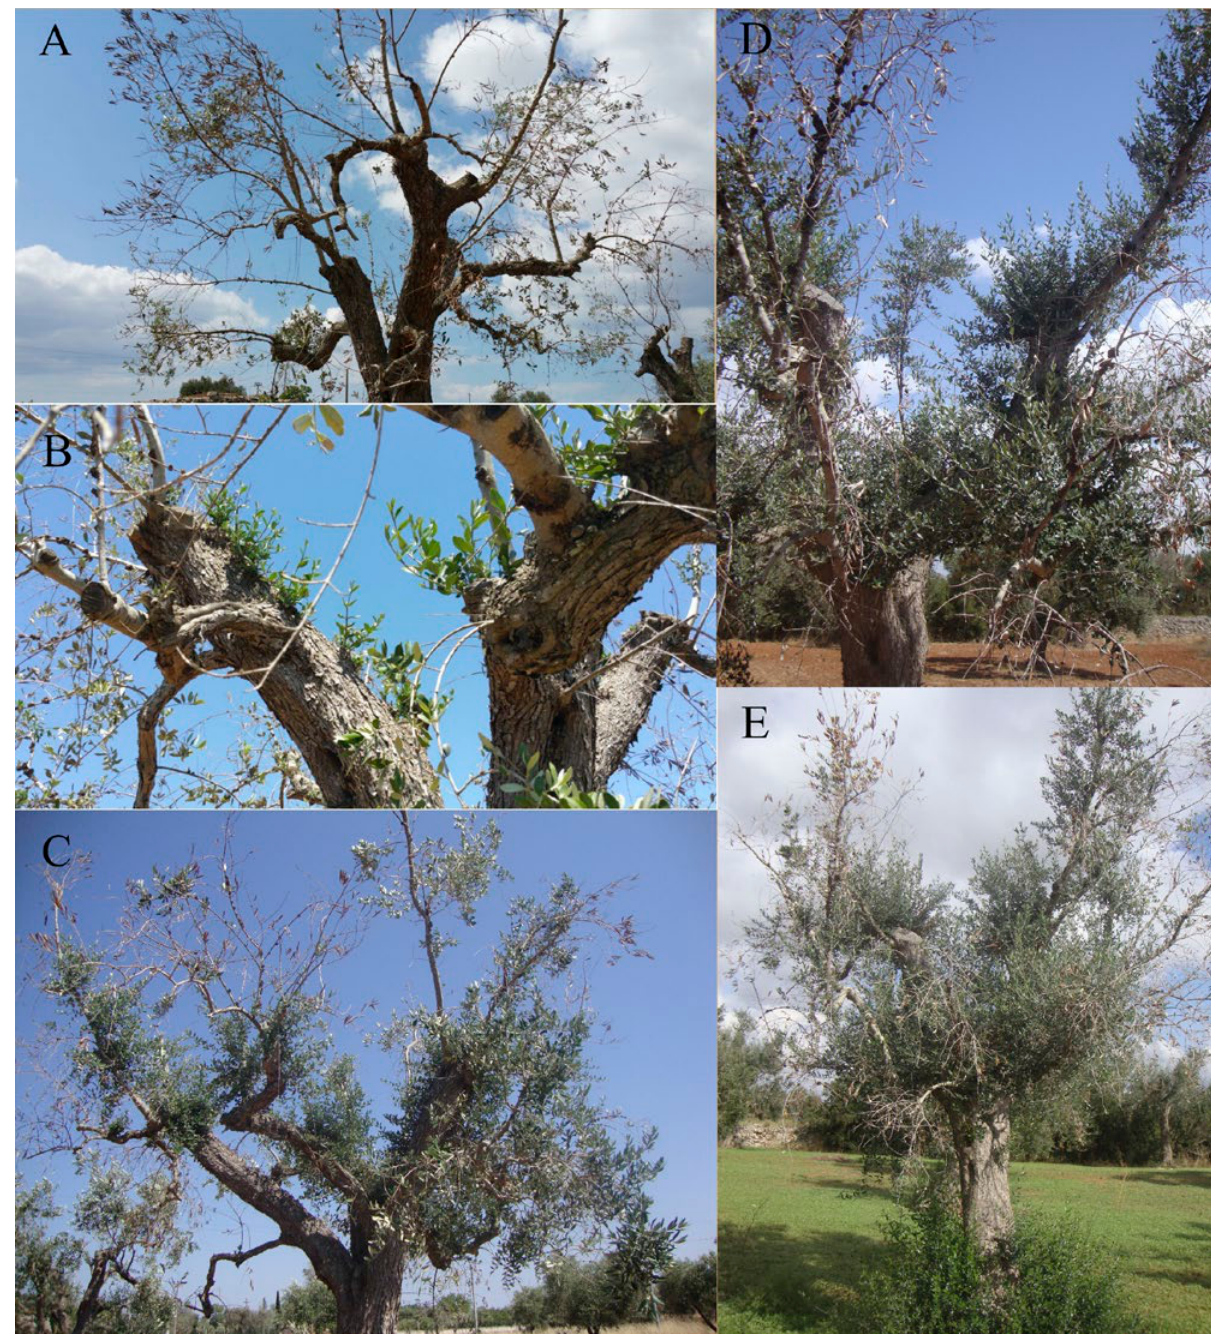
Figure 9. Recovery of a cv. Ogliarola salentina olive tree severely damaged (more than 80% of the canopy dead) by Xylella fastidiosa subsp . pauca grown in Galatone (Lecce province) after trunk injection with Dentamet® from April 2017 to July 2017 (see text for details). A: the tree before treatment. B: initial re-sprouting in May of shoots from the main tree branches as observed 20 d after treatment. C: new shoots continued to grow during June. D: at the end of July, part of the canopy was developed. E: despite the drought occurring during summer 2017, the tree showed in September a number of suckers as well as part of the